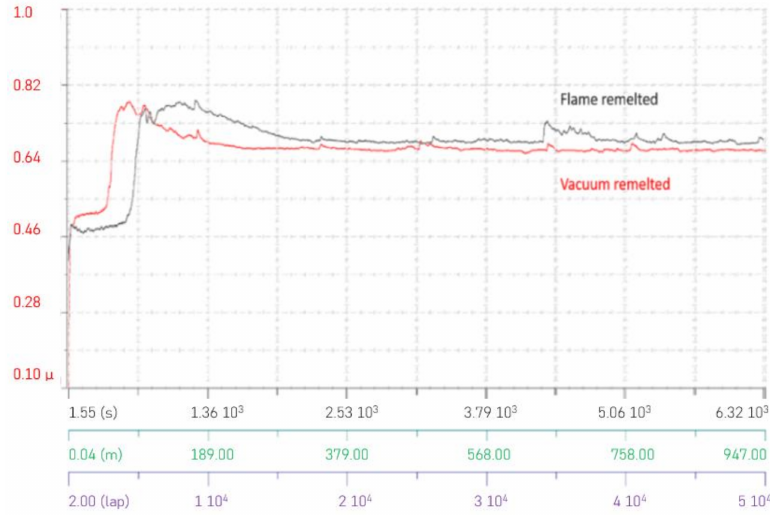
Figure 10. Graph highlighting the COF behavior.